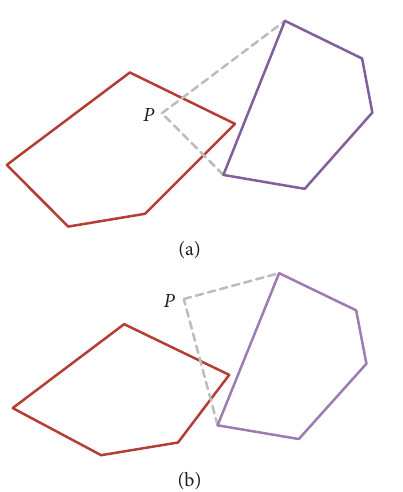
Figure 7: Aggregate invasion case. (a) Point P on the aggregate. (b) Point P outside the aggregate.